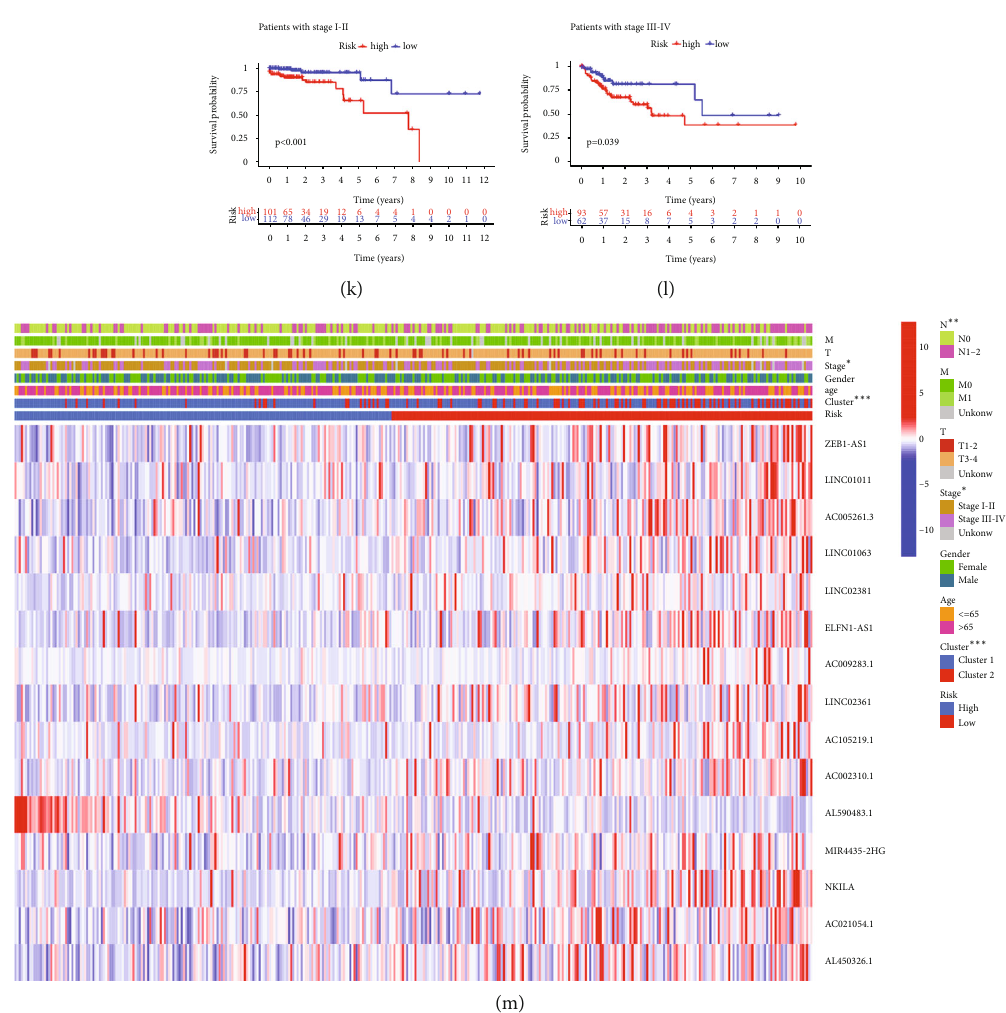
Figure 6: The Kaplan-Meier survival subgroup analysis for the prognostic signature of 15 ferroptosis-related lncRNAs strati fi ed by clinical characteristics. (a, b) patients aged > 65 yearsand ≤ 65years . (c, d) Female and male. (e, f) T1-2 and T3-4. (g, h) N0 and N1-2. (i, j) M0 and M1. (k, l) Stages I – II and III – IV. (m) Heatmap for di ff erential clinicopathological features of high- and low-risk